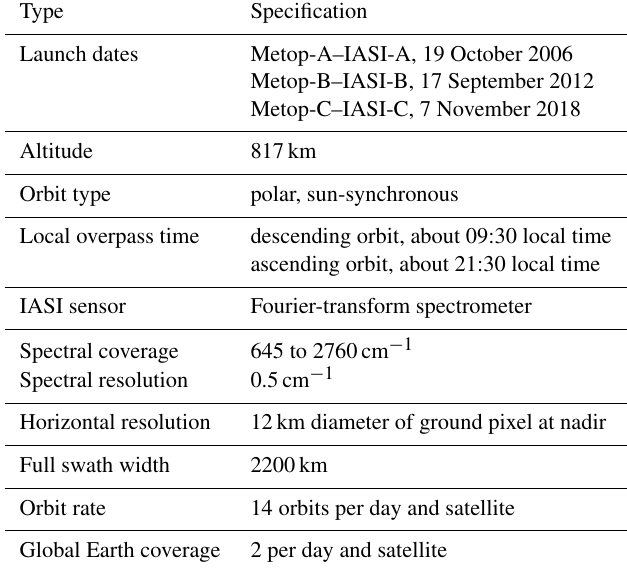
Table 1. Overview of specifications of IASI on